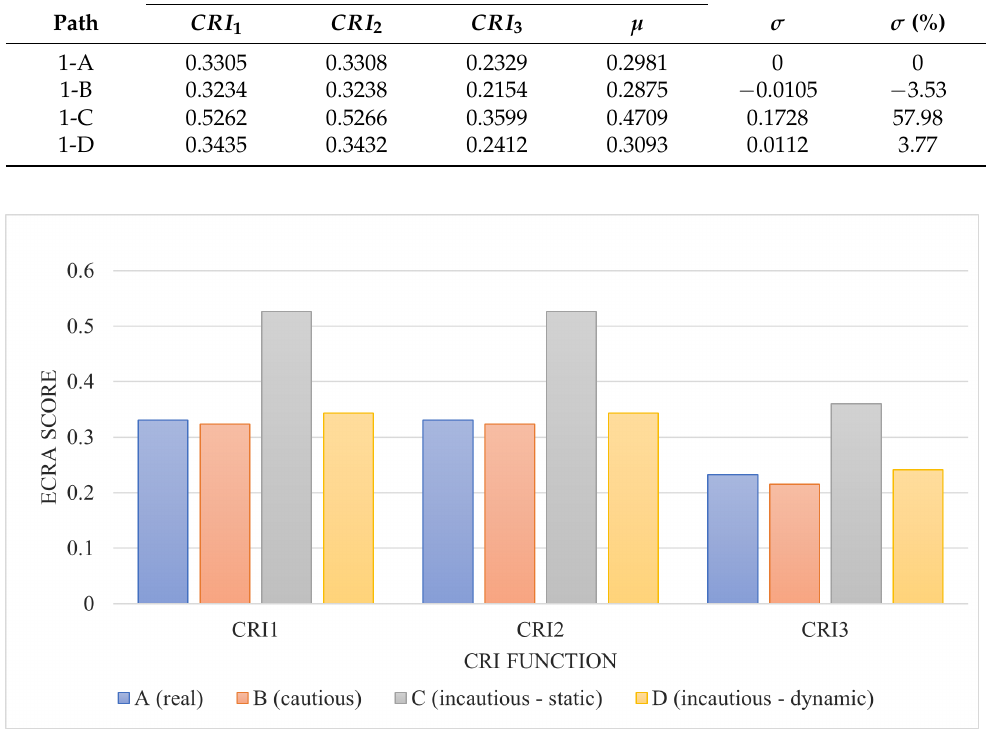
Table 3. ECRA score in test case 1 for four own ship (OS) paths using three different collision risk index (CRI) methods. ECRA Score